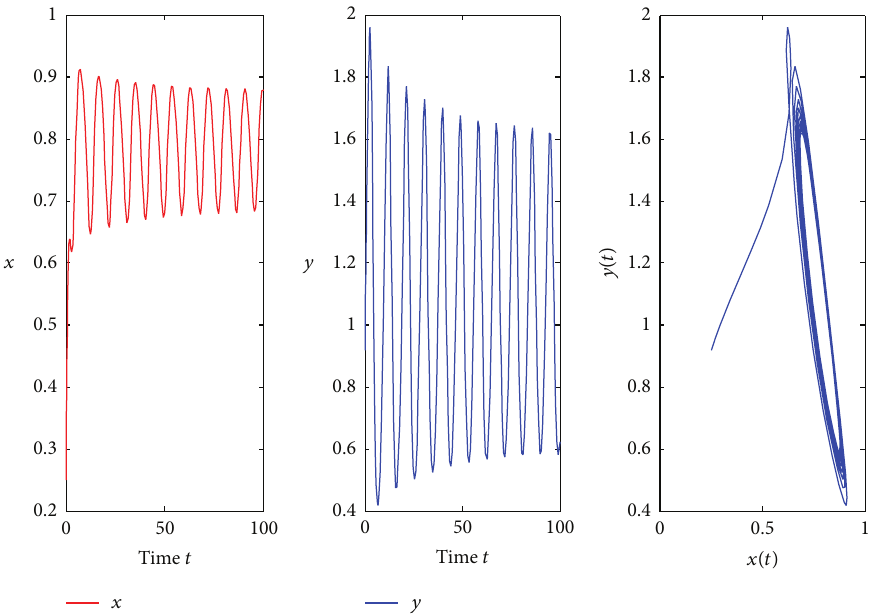
Figure 8: 𝐸 ∗ is unstable for 𝜏 1 = 0.15, 𝜏 2 = 1.95 > 𝜏 ∗ 20 = 1.8062 with initial values